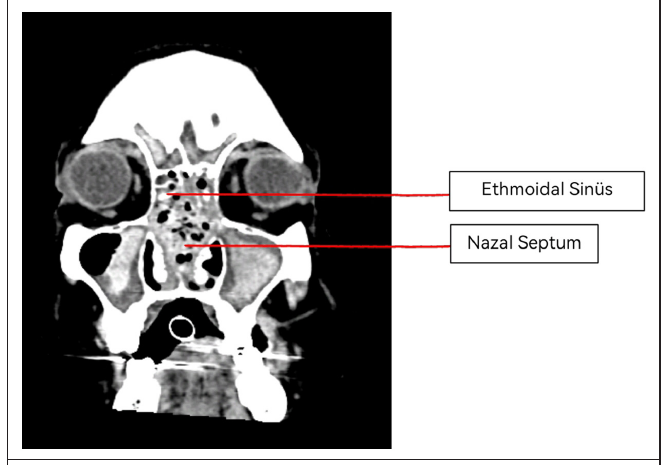
Figure 2. Widespread defective appea rance —infl ammat ion in the nasal septum bone structure, ethmoidal cells, and bone structures in the medial of both